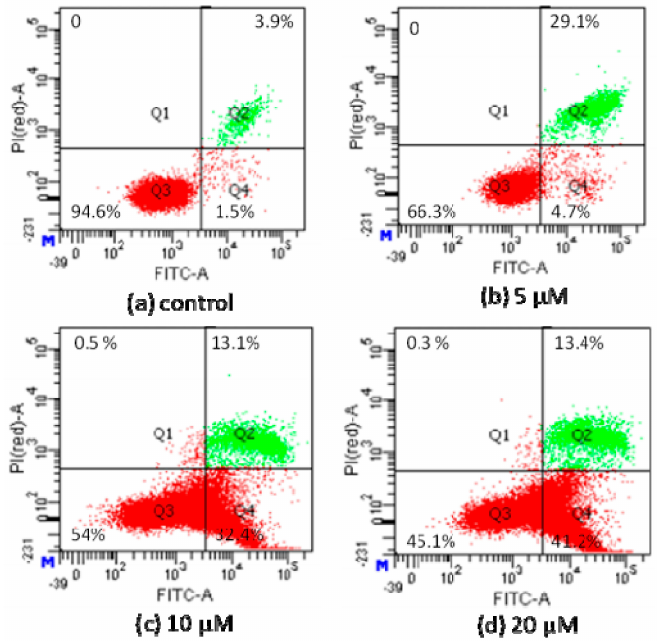
Figure 3. Apoptosis analysis of Bel-7402 cells induced by compound 14 using AnnexinV-FITC/PI staining: ( a ) control group; ( b ) 5 µ M; ( c ) 10 µ M; ( d ) 20 µ